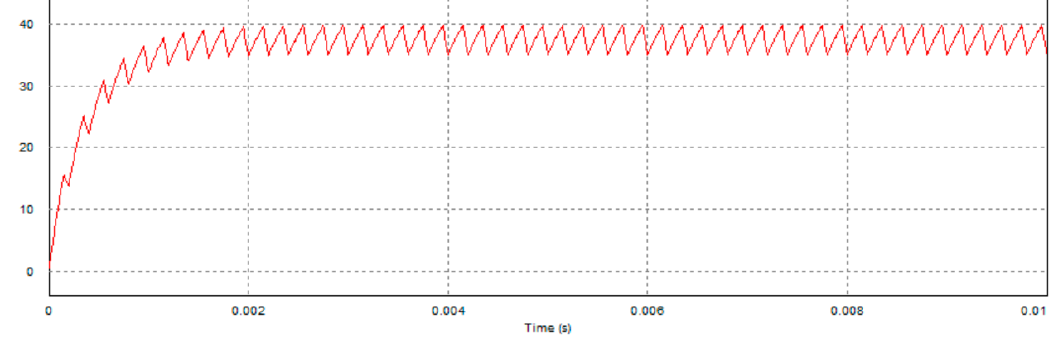
Figure 8. Simulating charge and discharge voltage of 200 μ F capacitor.